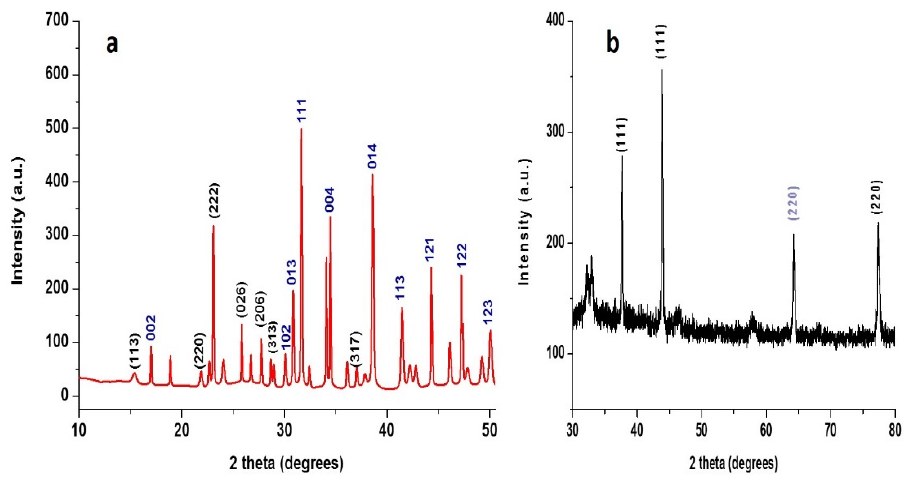
Figure 2. XRD patterns of prepared ( a ) S-NPs and ( b ) Cu-NPs.